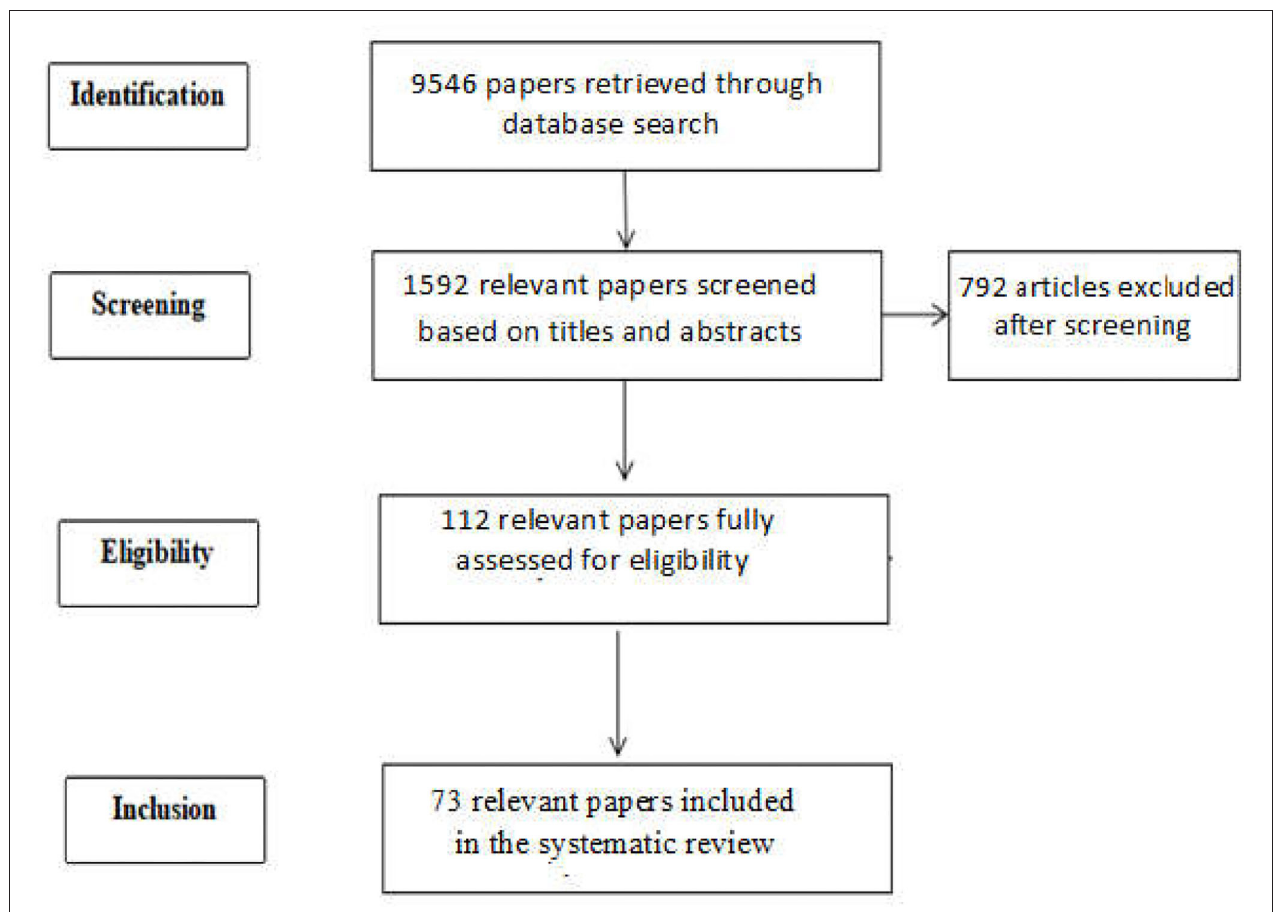
FIGURE 2 | The PRISMA flowchart illustrating the systematic review